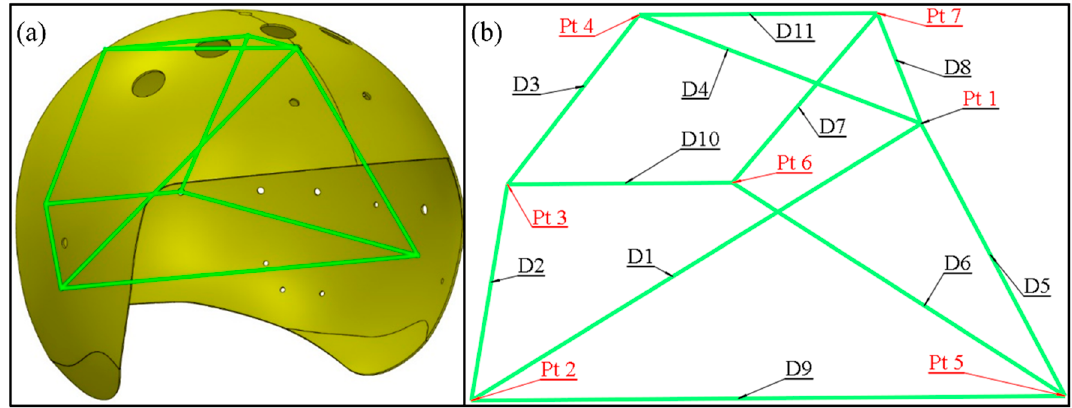
Figure 8. Feature points and feature distance: ( a ) The feature of CAD model; ( b ) Feature note. Table 6. Configuration of feature points and feature distance.